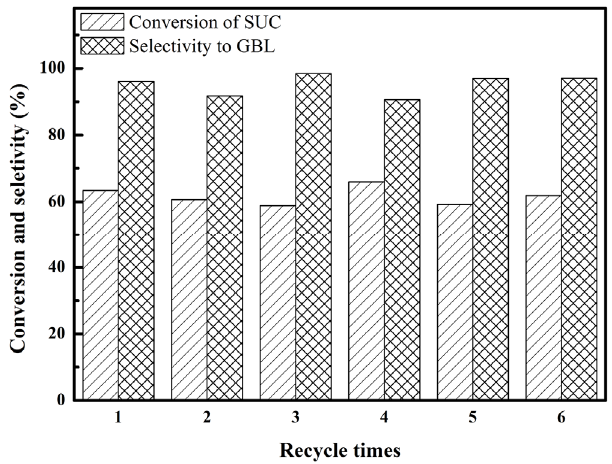
Figure 5. Recycling experimental results of 0.2 Pd/ZrO 2 catalyst.